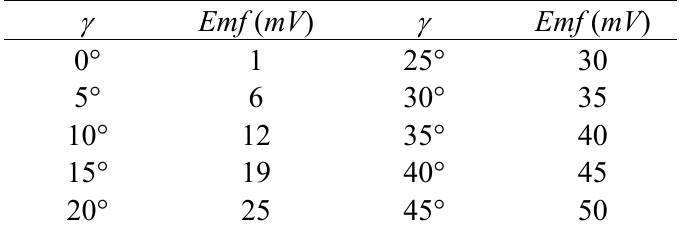
Table 4. The Emf signal produced by a sensor coil in the rotational angle experiment.